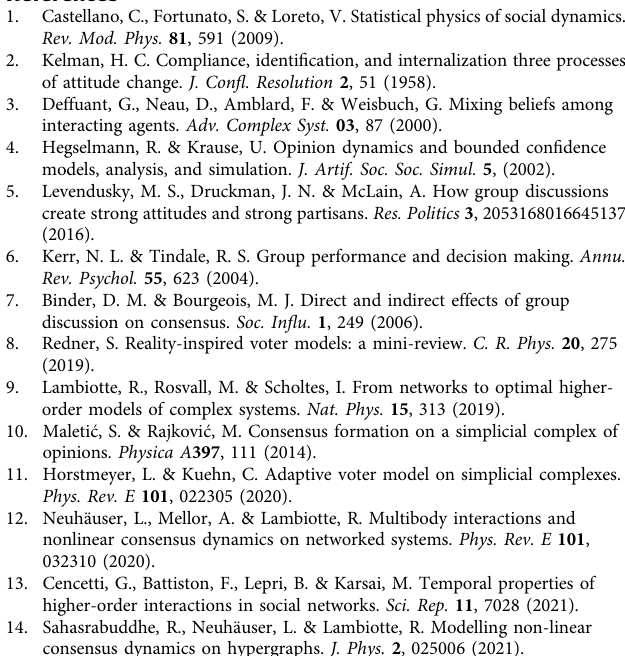
Fig. 10. This results in a mean degree of c = 12. The second case is a fi ve-uniform hypergraph, where hyperedges connect up to the third nearest-neighbour nodes as shown on the right of Fig. 10. This results in a mean degree of c = 15.